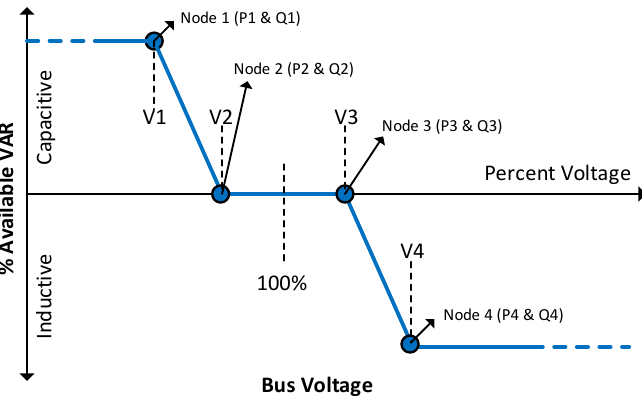
Figure 1. Array Settings of type-3 DER’s Volt-VAR behavior.